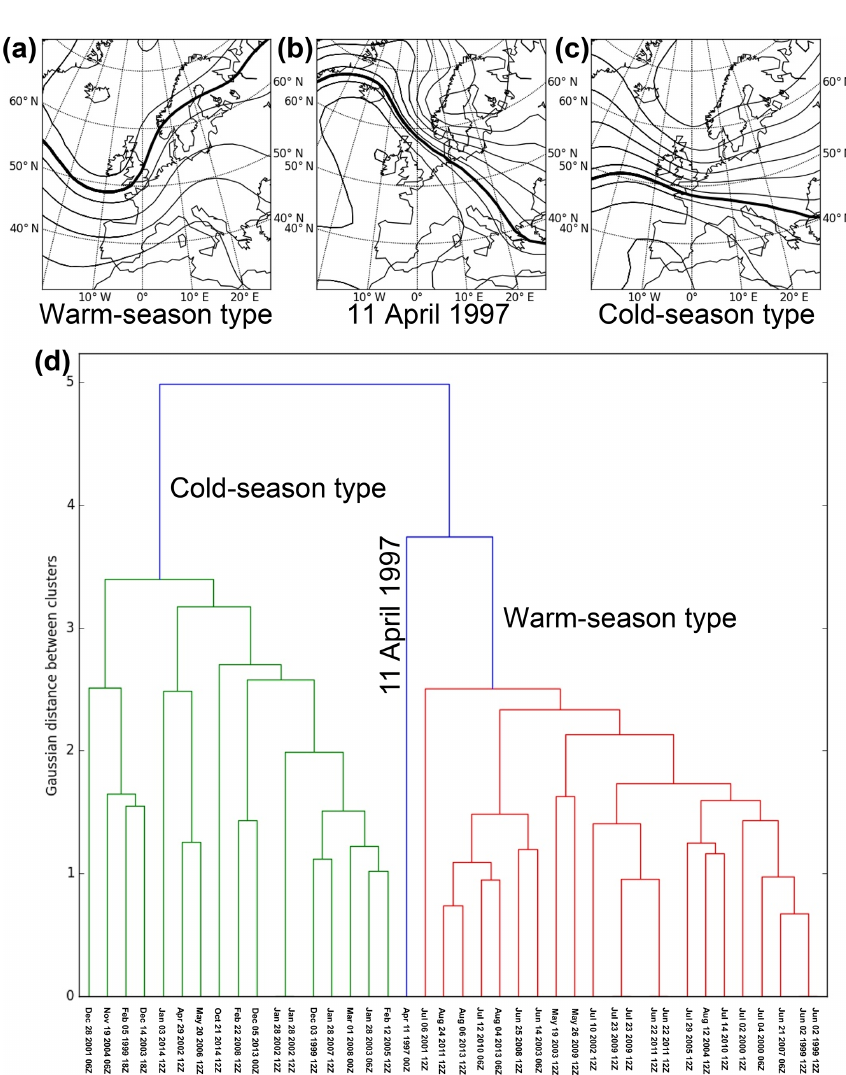
Figure 4. (a) Averaged 500hPa geopotential field of the warm-season-type derecho cluster (1997–2014). Isohypses are displayed in 80m intervals; the 5600m isohypse is highlighted by the thick line. (b) The 500hPa geopotential field of 11 April 1997 00:00:00UTC. (c) Av- eraged 500hPa geopotential field of the cold-season-type derecho cluster (1997–2014). (d) Dendrogram of the cluster analysis of 500hPa geopotential fields in German derecho events (1997–2014). Dates of the analysis fields are given below each event line. The names of the clusters (a–c) are also given in the dendrogram. The maps in (a–c) have been produced with the python module